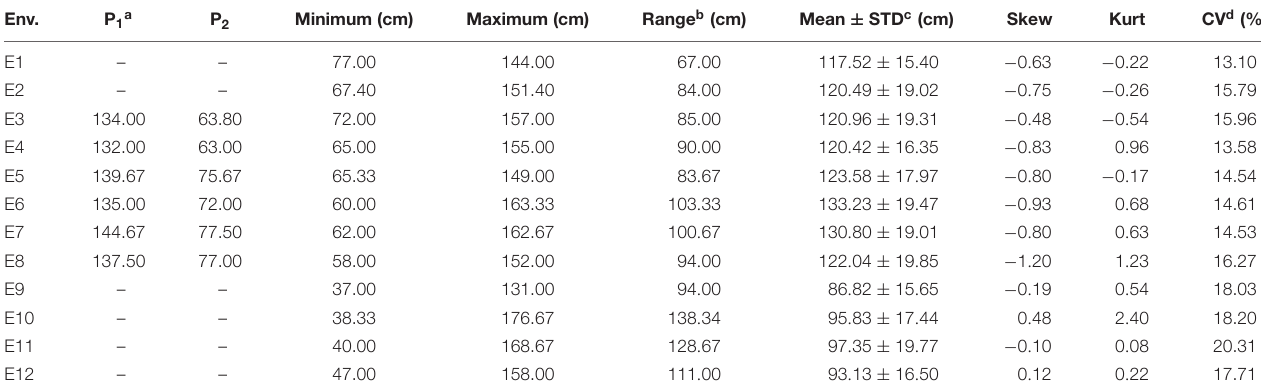
TABLE 1 | Descriptive statistics for soybean plant height of RIL6013 population in eight environments and 455 germplasm resources in four environments.